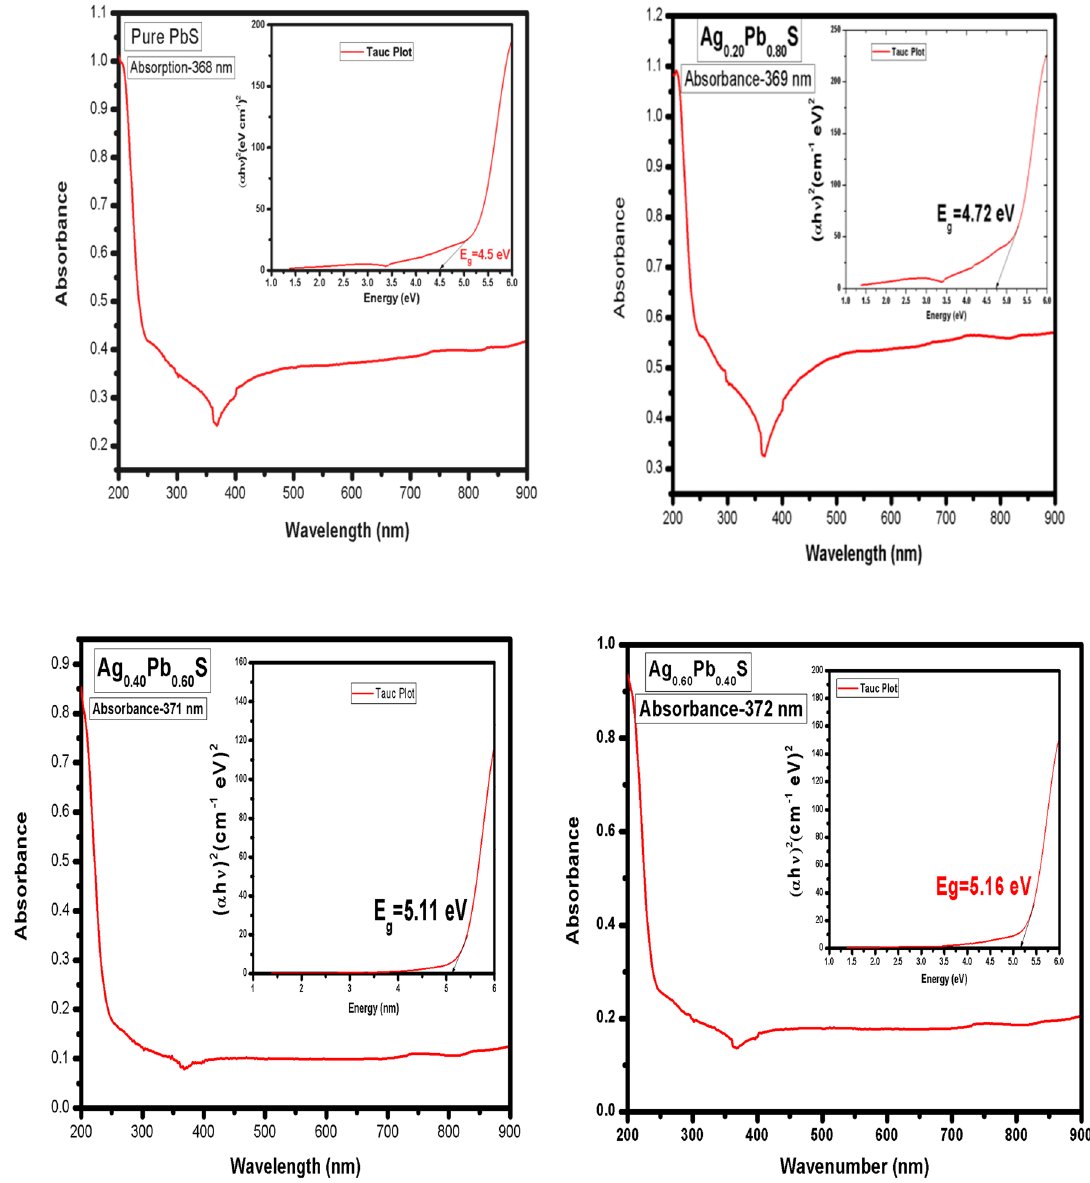
Figure 6: UV - Vis absorption spectra for pure PbS and Ag:PbS at di ff erent concentrations: ( a ) 20%, ( b ) 40%, and ( c ) 60%.